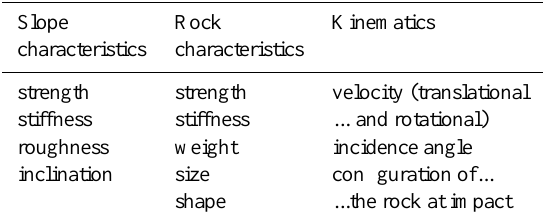
Table 2. Parameters assumed to influence the bouncing phe- nomenon (Labiouse and Descoeudres, 1999). Slope Rock Kinematics characteristics characteristics strength strength velocity (translational stiffness stiffness ... and rotational) roughness weight incidence angle inclination size configuration of...